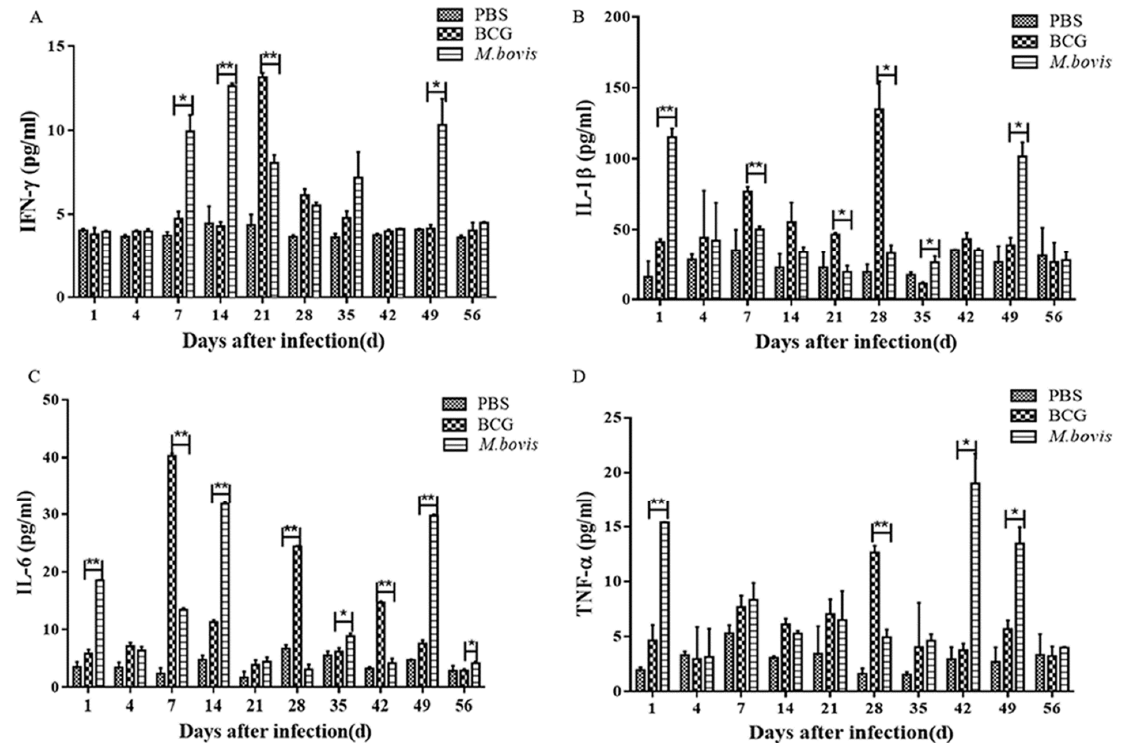
Figure 8. Serum cytokine production in mice infected with M. bovis and BCG. The mice were infected by tail vein injection with 2 × 10 5 CFU each and euthanized on 1, 4, 7, 14, 21, 28, 35, 49, and 56 days post-infection. The serum concentrations for IFN-γ ( A ), IL-1β ( B ), IL-6 ( C ), and TNF-α ( D ) were determined with commercial ELISA. The data are shown as the mean ± SD of three replicates, where *, **, and *** represent p < 0.05, p < 0.01, and p < 0.001, respectively.